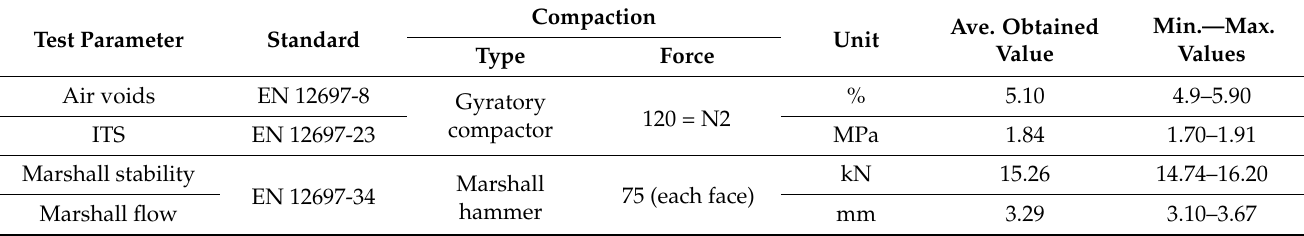
Table 5. The post-production laboratory quality control of the base/binder